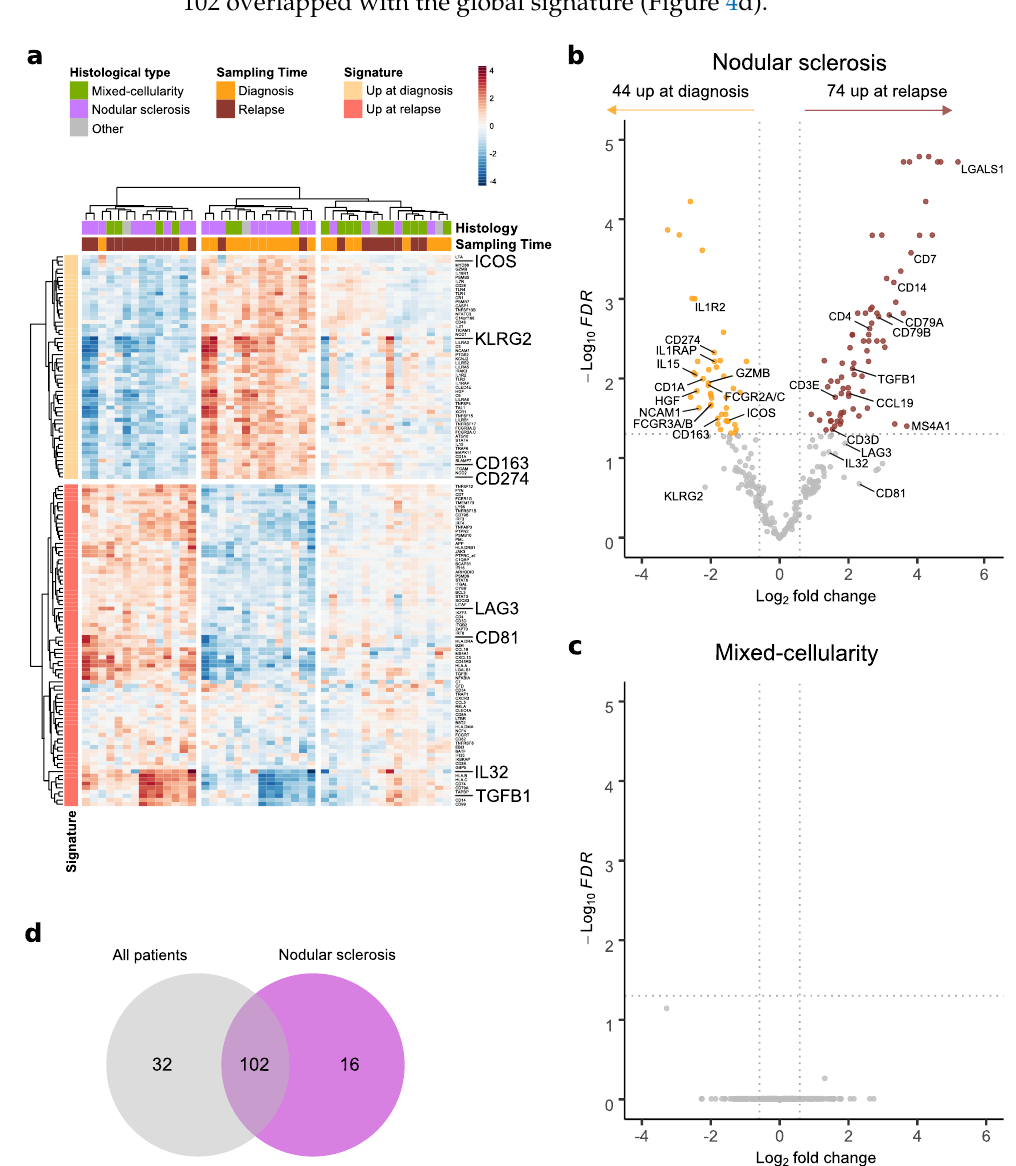
Figure 4. Differential gene expression analysis in paired diagnostic and relapse samples according to histological subtypes of classical Hodgkin lymphoma: ( a ) heatmap of the significantly dereg- ulated genes between relapse and diagnosis (see Figure 3a and Supplementary Table S2) across all paired samples, annotated by sampling timepoint and histological subtype (log2 fold change); ( b ) and ( c ) volcano plot displaying differentially expressed genes (FDR < 0.05 and |fold change| > 1.5) between diagnostic and relapse samples in the nodular sclerosis subtype and in the mixed-cellularity subtype, respectively; ( d ) Venn diagram displaying the intersection of differentially expressed genes (FDR < 0.05 and |fold change| > 1.5) between relapse and diagnosis from all paired samples and nodular sclerosis sub-cohorts. FDR = False Discovery